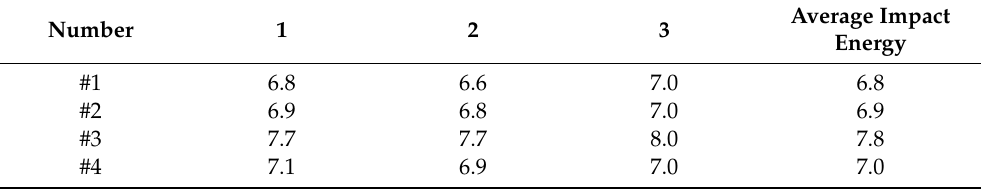
Table 7. Impact energy of the matrix and di ff erent composite materials (J · cm − 2